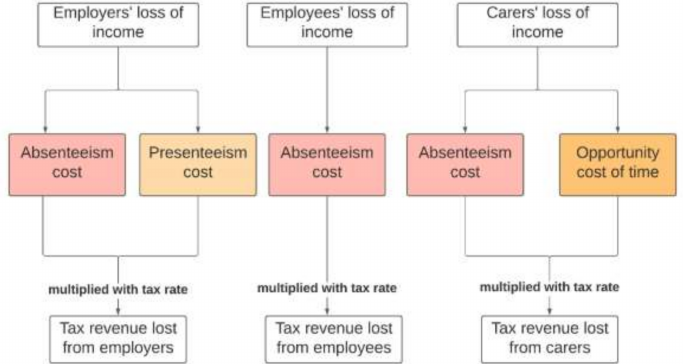
Figure 4. Estimating the economic cost of LHL to the